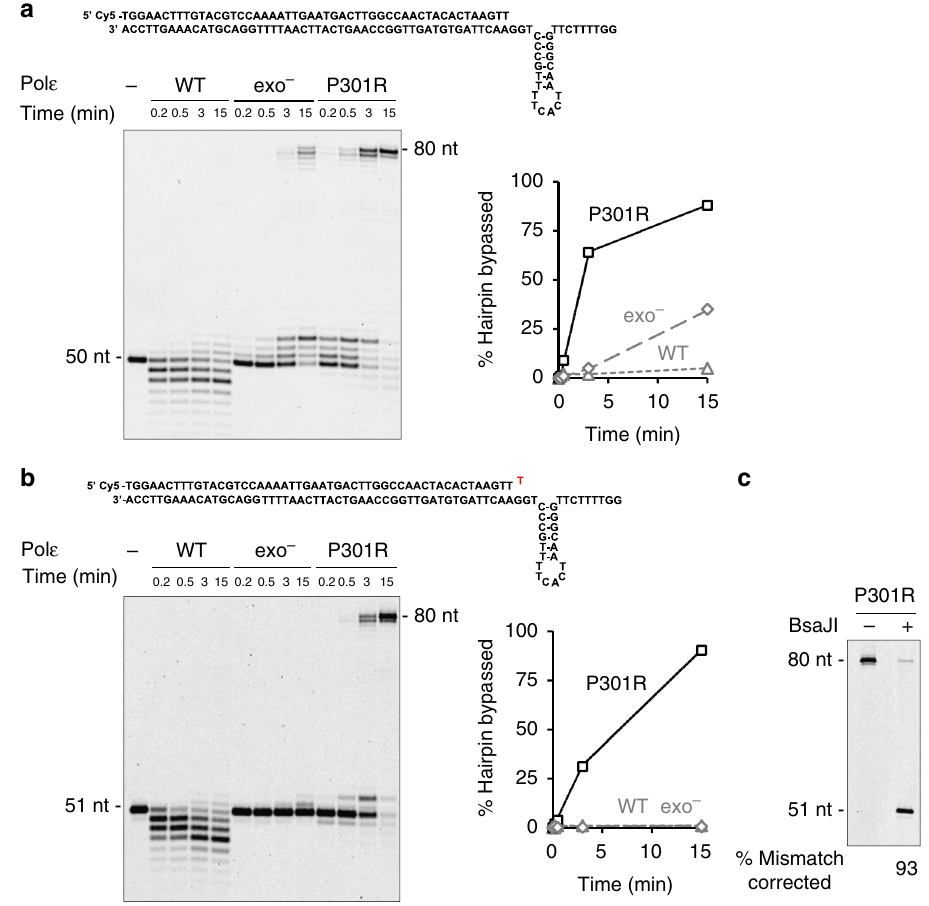
Fig. 5 Increased bypass of hairpin DNA structures by Pol ε -P301R. The polymerase and DNA substrate concentrations are as in Fig. 3a. a DNA polymerase activity was assayed on P50/T80H oligonucleotide substrate containing 6-bp inverted repeats in the template region, and the fraction of products longer than 71 nt indicating hairpin bypass was quanti fi ed. Representative of three independent experiments. b DNA polymerase activity was assayed on P51T/ T80H oligonucleotide substrate containing inverted repeats in the template region and a terminal G-T mismatch, and the fraction of products longer than 71 nt indicating hairpin bypass was quanti fi ed. Representative of four independent experiments. c Pol ε -P301R was incubated with the P51T/T80H substrate for 30 min, and relative ef fi ciency of mismatch extension vs . proofreading was determined by BsaJI digestion of the reaction products as in Fig. 4b. One experiment. Source data are provided in a Source Data fi